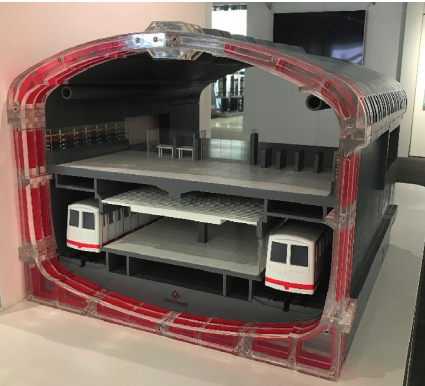
Figure 1: Model of prefabricated metro